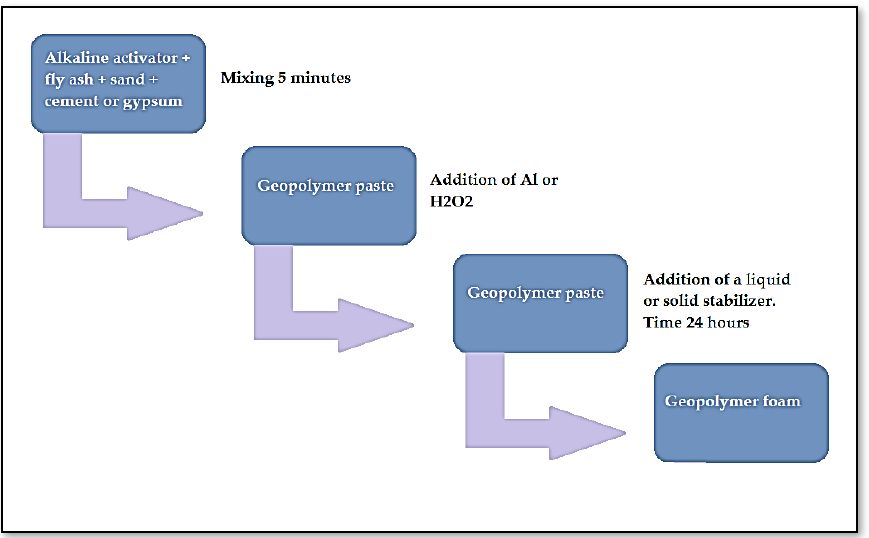
Figure 3. The process of producing foamed geopolymers with the addition of stabilizers.